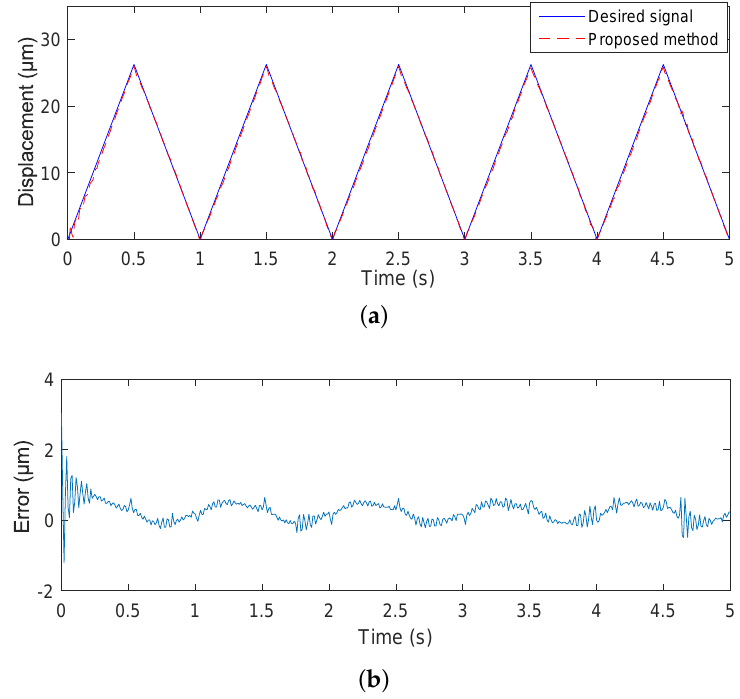
Figure 9. Experimental results of the piezoelectric actuated stage with the triangular wave signal. ( a ) tracking curve of the piezoelectric actuated stage; ( b ) tracking